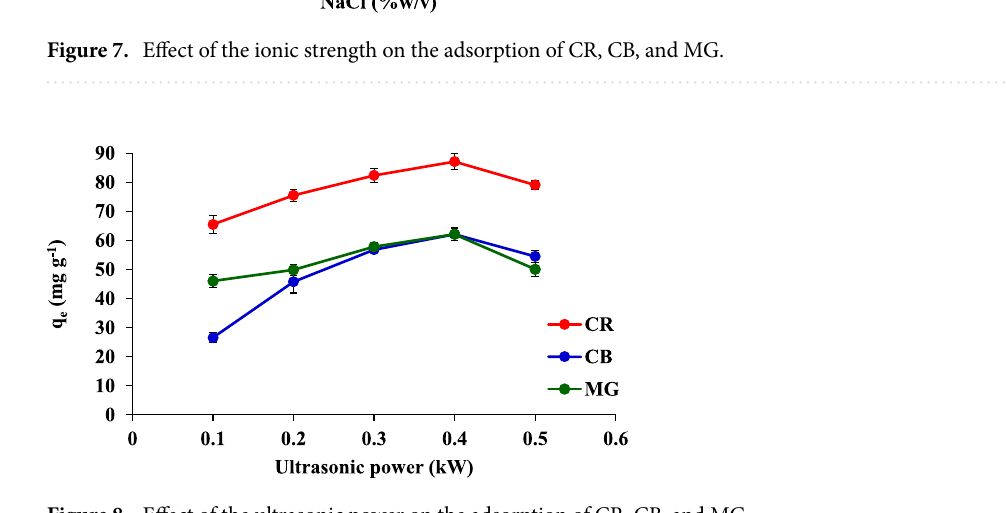
Figure 8. Effect of the ultrasonic power on the adsorption of CR, CB, and